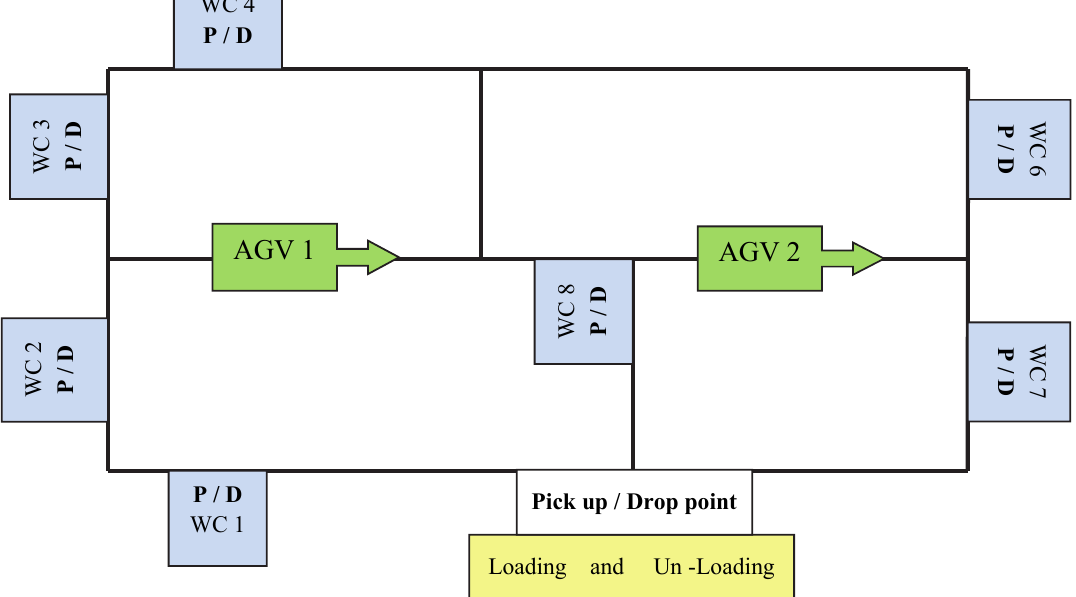
Fig. 4. The FMS layout 2 consisting of 8 numbers of work center and one loading and unloading center.